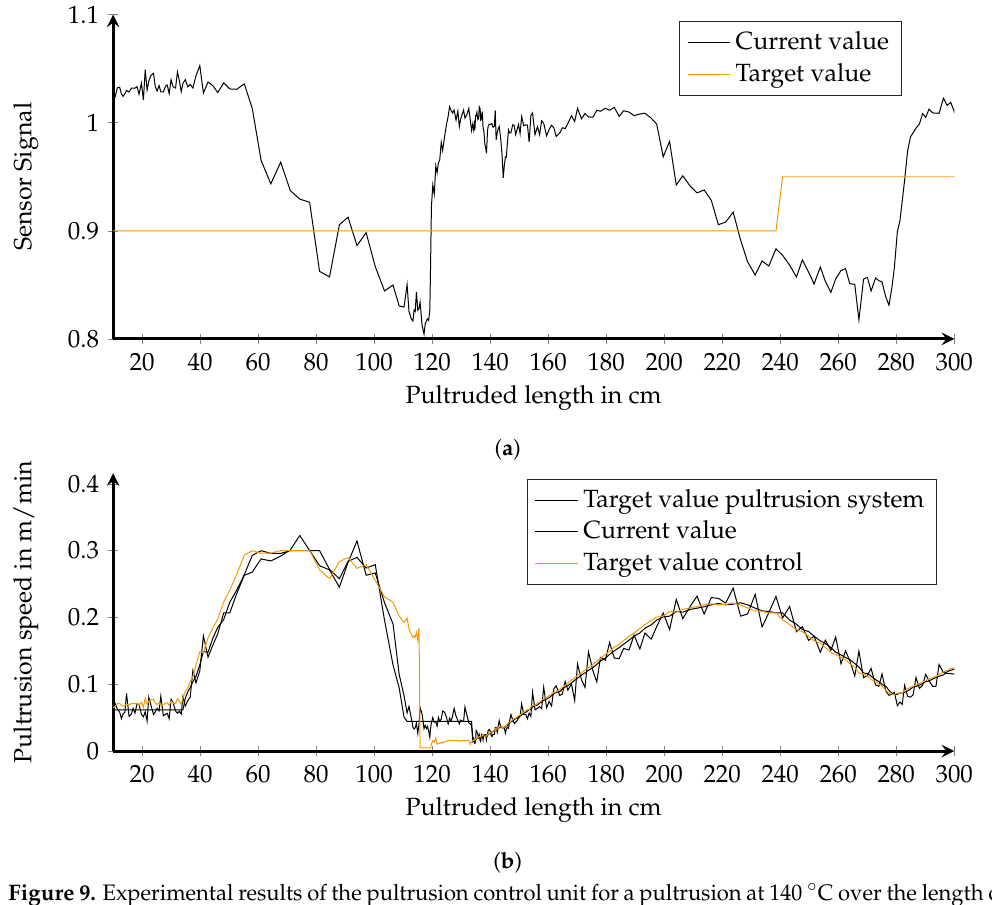
Figure 9. Experimental results of the pultrusion control unit for a pultrusion at 140 ◦ C over the length of the pultruded material between 10 and 300 cm. ( a ) Sensor signal between 10 and 300 cm; ( b ) pultrusion speed between 10 and 300 cm.